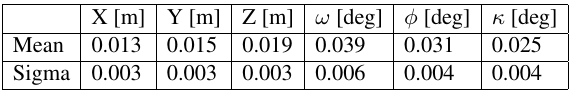
Table 1. Bundle block adjustment: Absolute camera position and